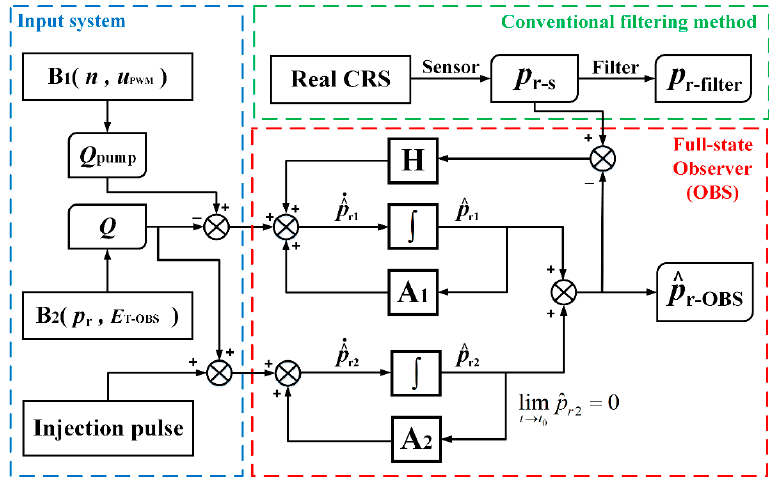
Figure 2. Schematic of the working principle for the OBS method.